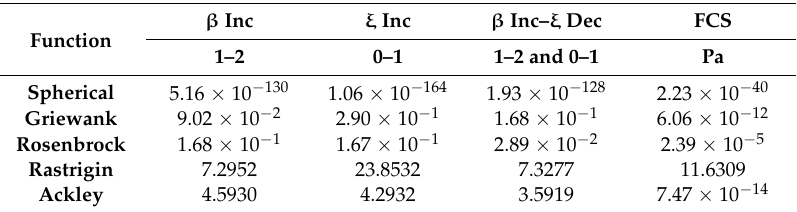
Table 10. Comparison with FICA and Fuzzy Cuckoo Search (FCS) (pa).